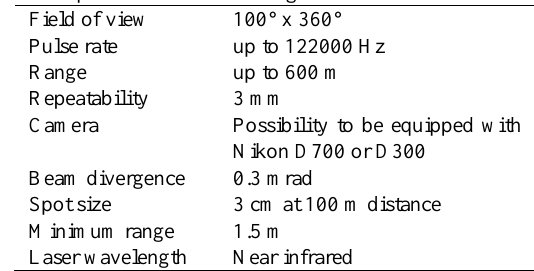
Table 1. Specifications of the Riegl VZ-400.